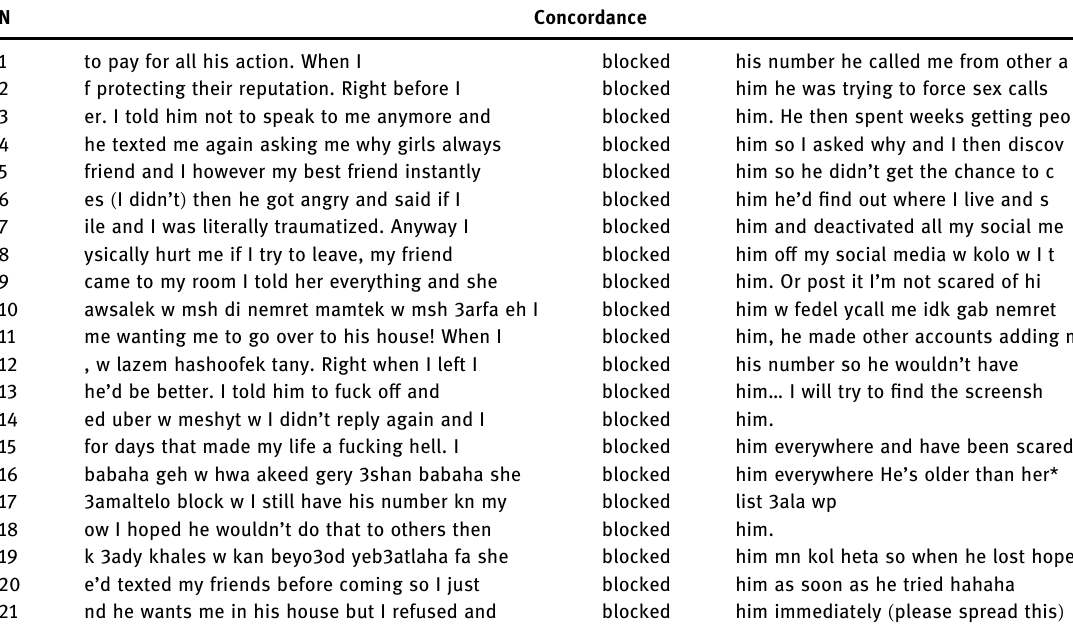
Table 41: Concordance lines for